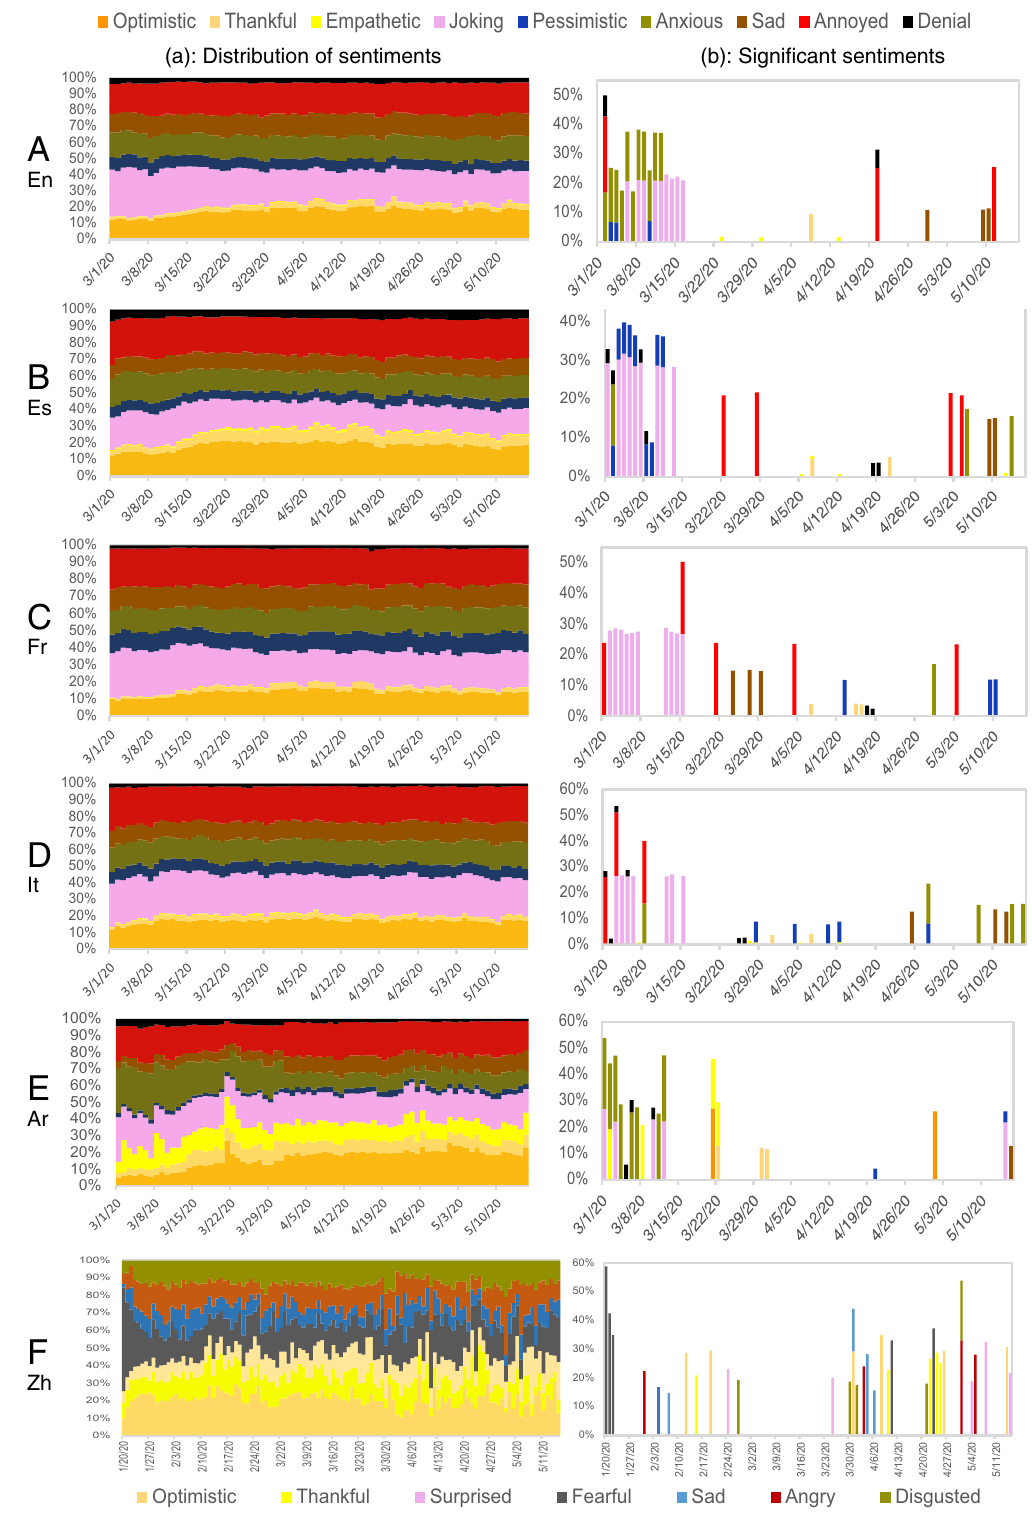
Fig. 2 Shifting sentiments in COVID-19 related conversation. A – F (a) Variations in the sentiment distribution (as percentage) of tweets in the languages analyzed over time [English (En), Spanish (Es), French (Fr), Italian (It), Arabic (Ar), and Chinese (Zh)]; A – F (b) Signi fi cant sentiments identi fi ed as sentiment percentage values above the 95% con fi dence interval ( > N (cid:1) 1 ð 0 : 95 ; μ ; σ Þ , where μ and σ are the mean and standard deviation of the daily values of one sentiment,